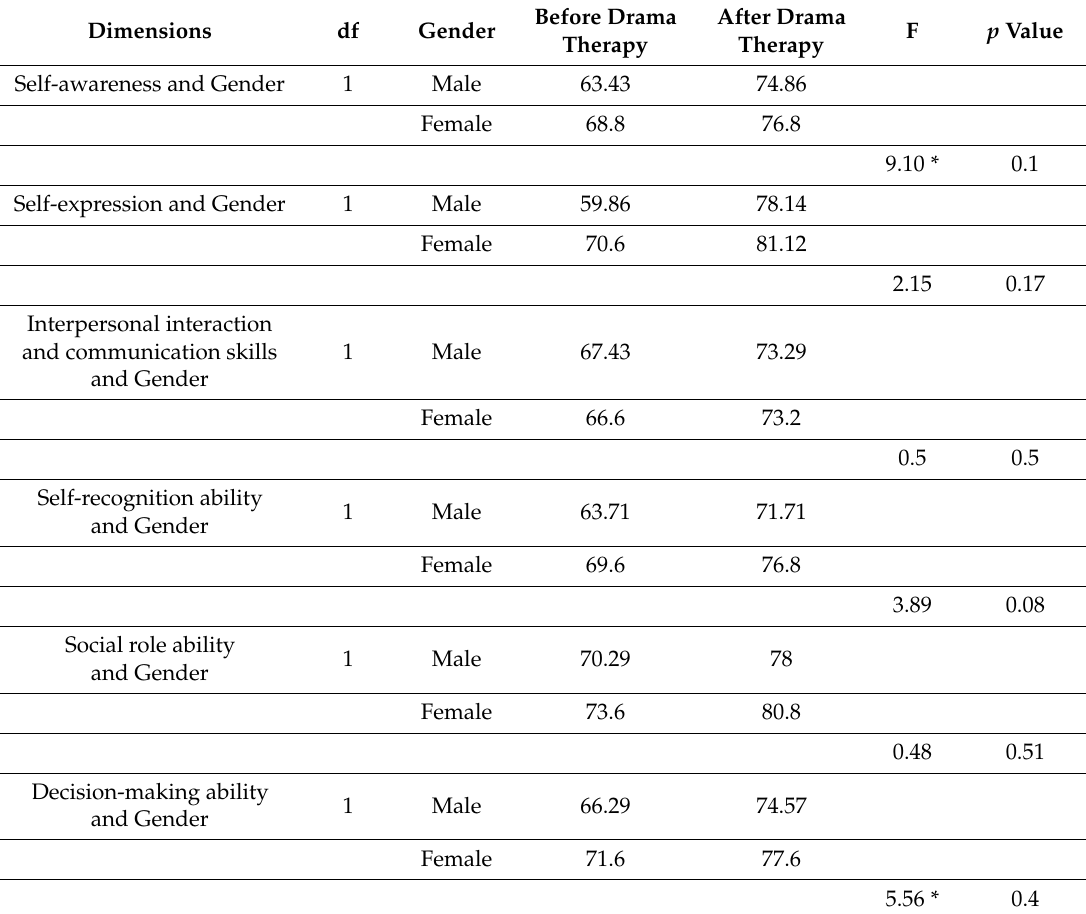
Table 4. Repeated measures ANOVA: The dimensions of evaluations and gender.